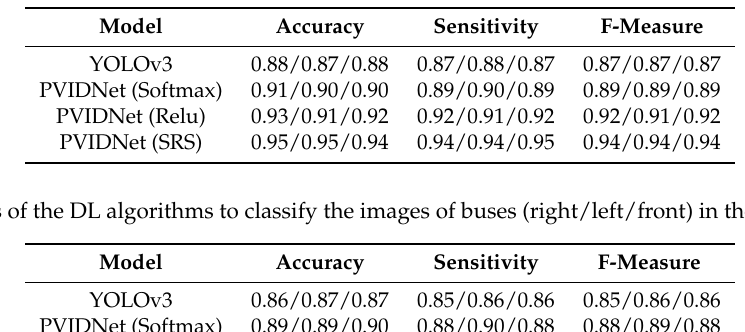
Table 5. Results of the DL algorithms to classify the images of fire trucks (right/left/front) in the training phase.